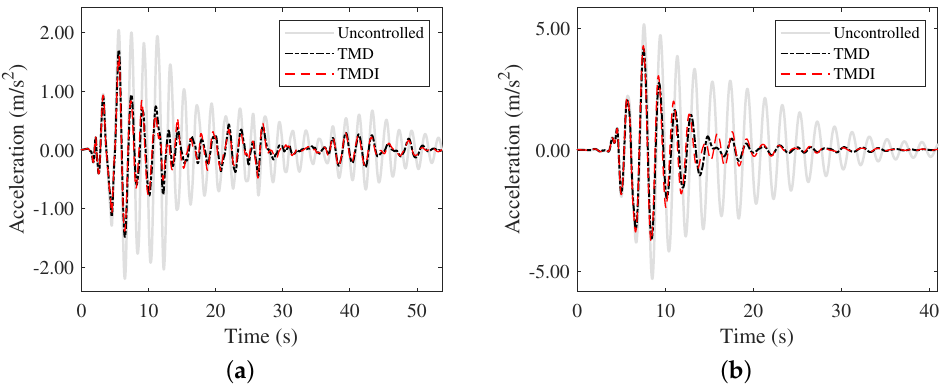
Figure 9. The absolute acceleration of the primary structure under earthquake: ( a ) EL Centro and ( b )